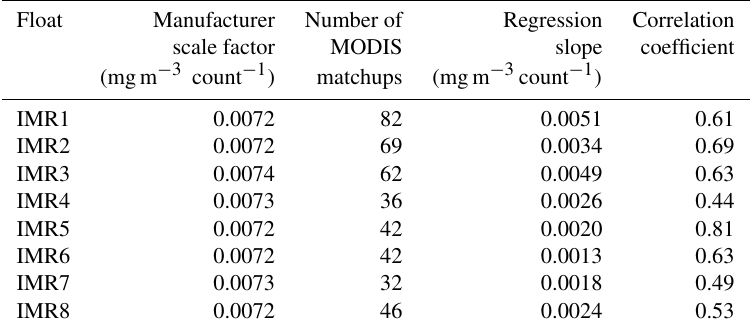
Table 2. Fluorometer scale factors provided by the manufacturer, number of MODIS match-ups, regression slopes determined by a regression through the origin and correlation coefficients between the float fluorescence (minus the dark counts) and MODIS [Chl a ] estimates.